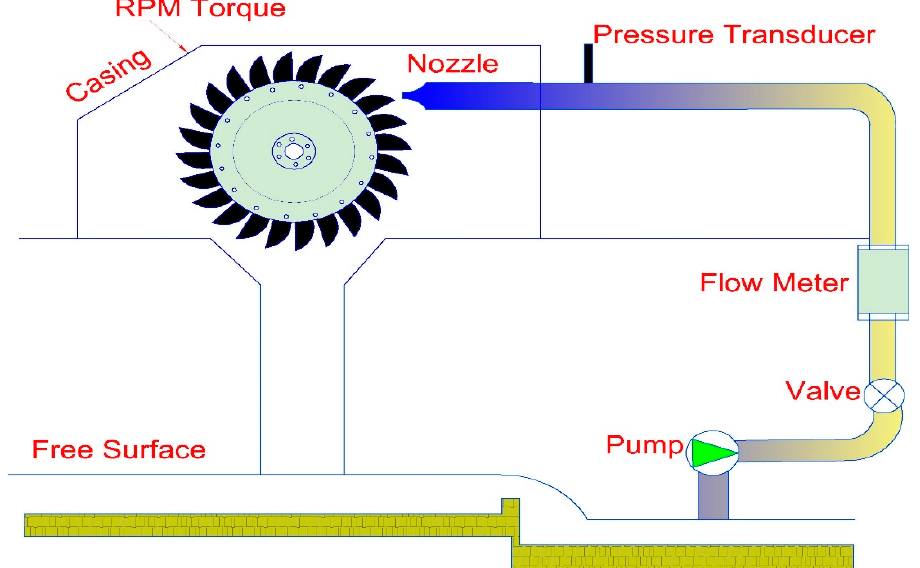
Figure 1. Pelton turbine system diagram .